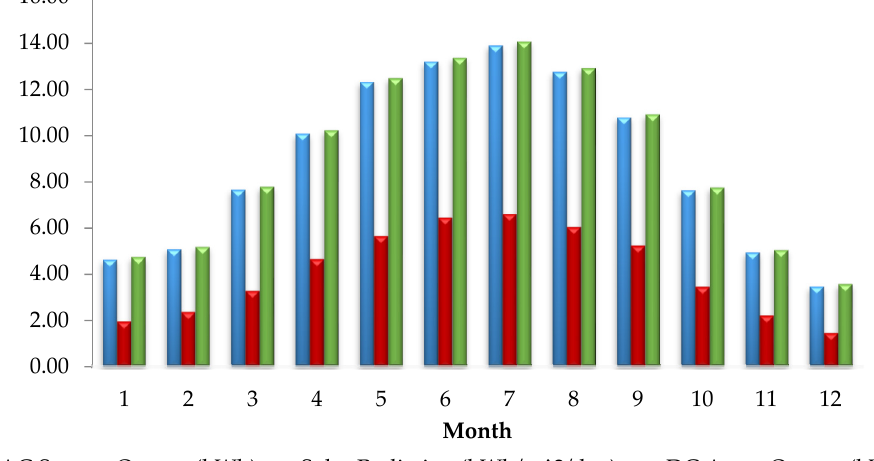
Figure 14. The annual the PVWatts ® data.